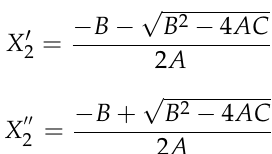
Table 2. Test results when the simple slope β 1 + β 12 X 2 was significant. X 2 is the moderator variable; X 2 min and X 2 max refer to the greatest and least values of X 2 , respectively; and X (cid:48) solutions of the binary first-order Equation (17) for X 2